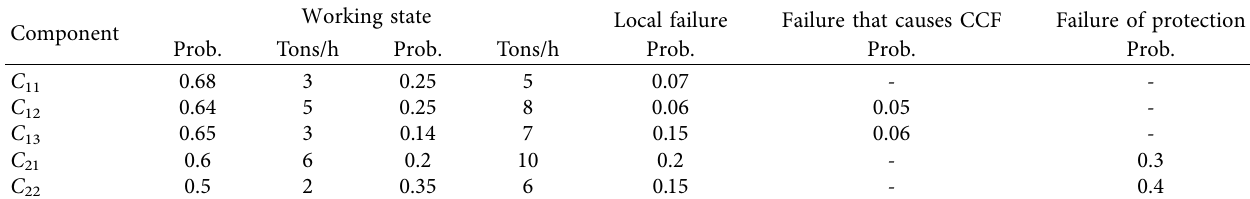
Table 1: Parameters of components.